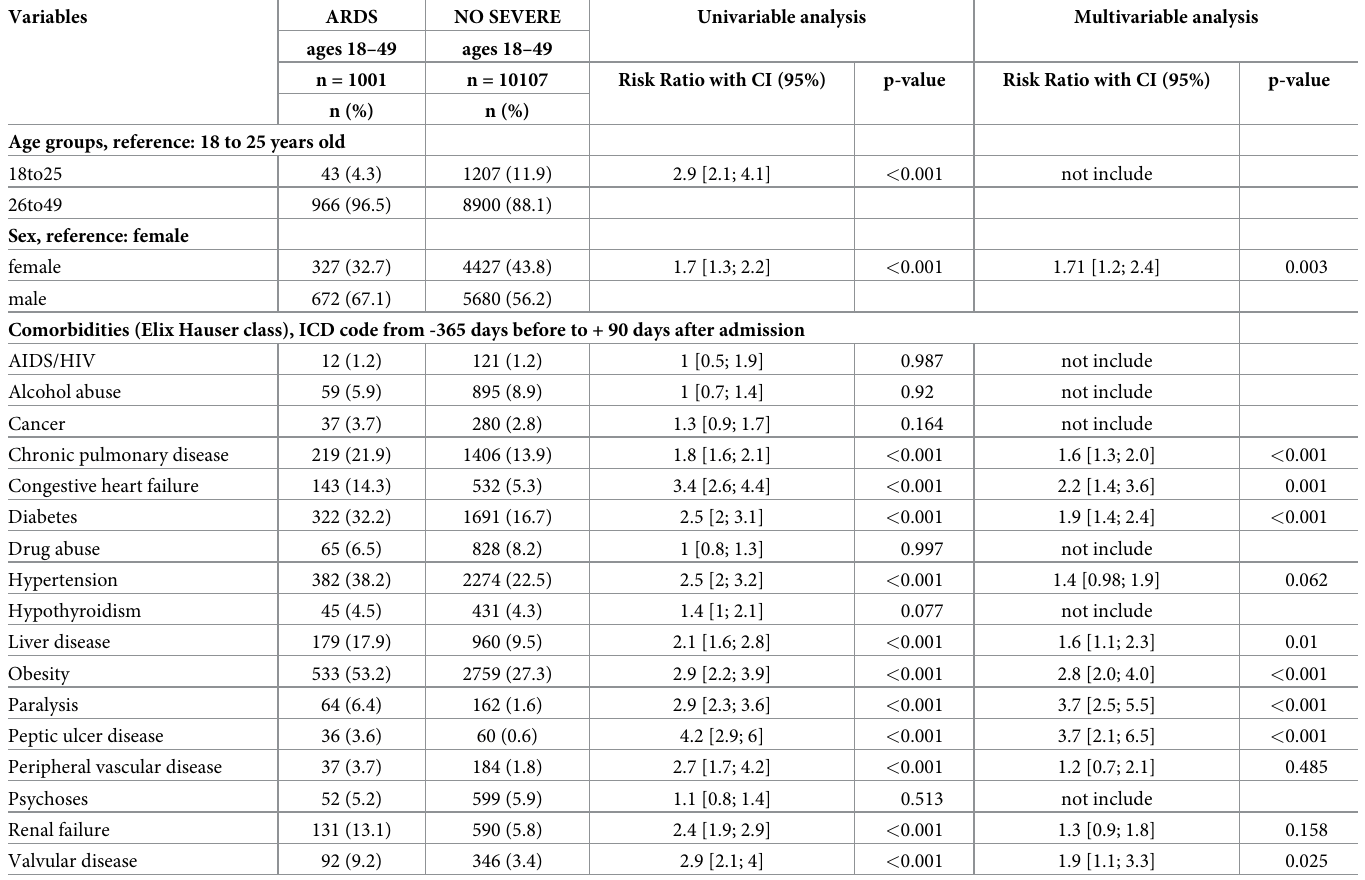
Table 2. Number and percentage of patients per age groups, per sex, per Elixhauser comorbidities for young adult patients with ARDS and non severe young adult patients. Risk ratio associated in uni- and multivariable analysis.